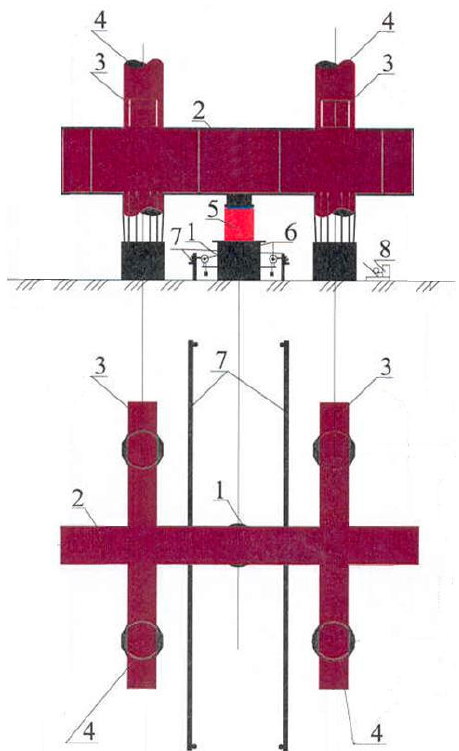
Figure 6. Scheme of the anchor-stop stand for the static load test. 1—tested pile with protective and bearing shell; 2—main I-beam No.70; 3—secondary beams No.40; 4—anchor piles (steel pipes); 5—